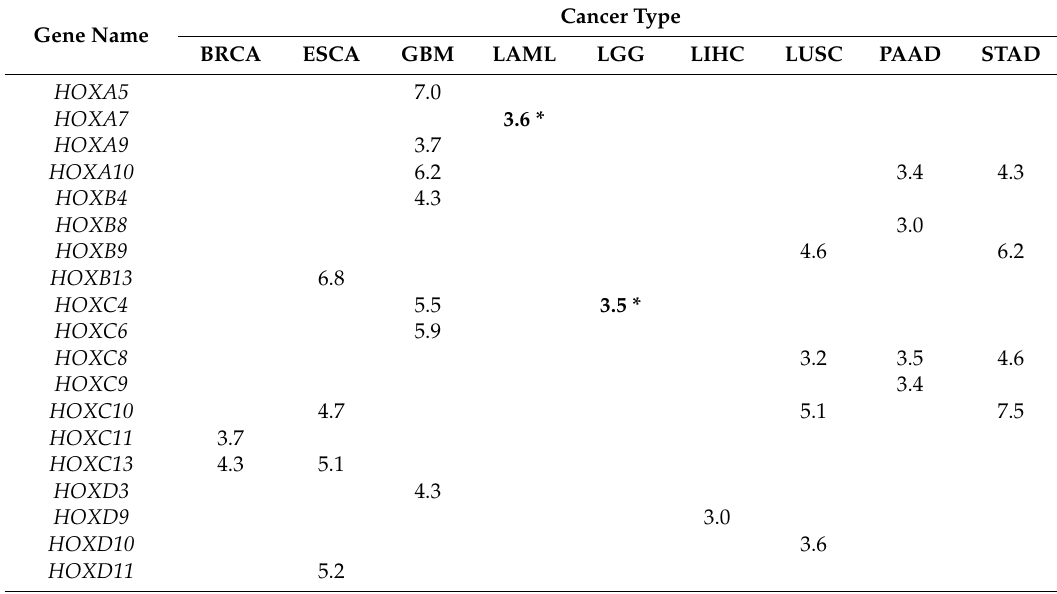
Table 2. HOX genes with pronounced expression change between healthy and tumor tissues 1 .